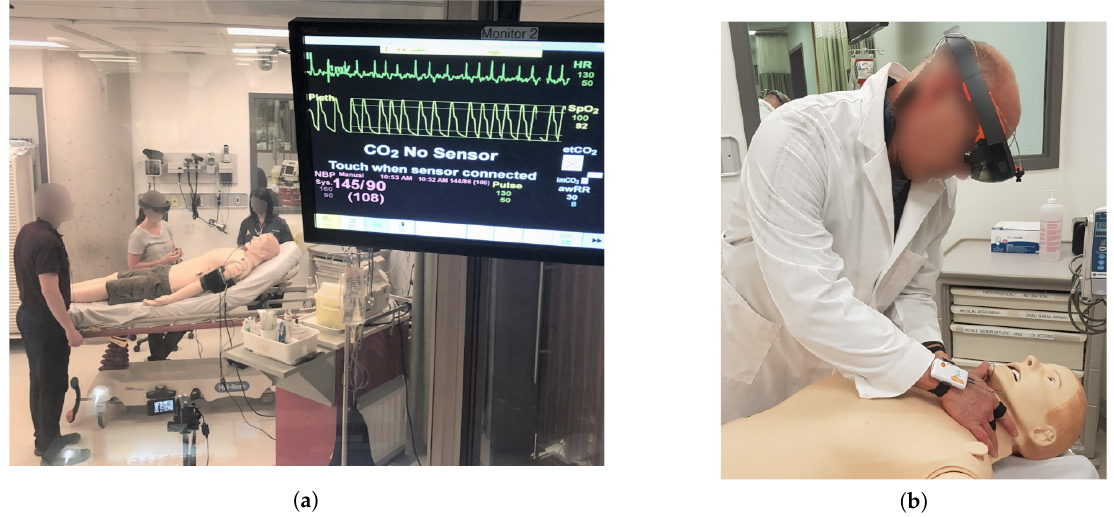
Figure 2. ( a ) Simulation environment with trauma team; ( b ) Instrumentation worn by